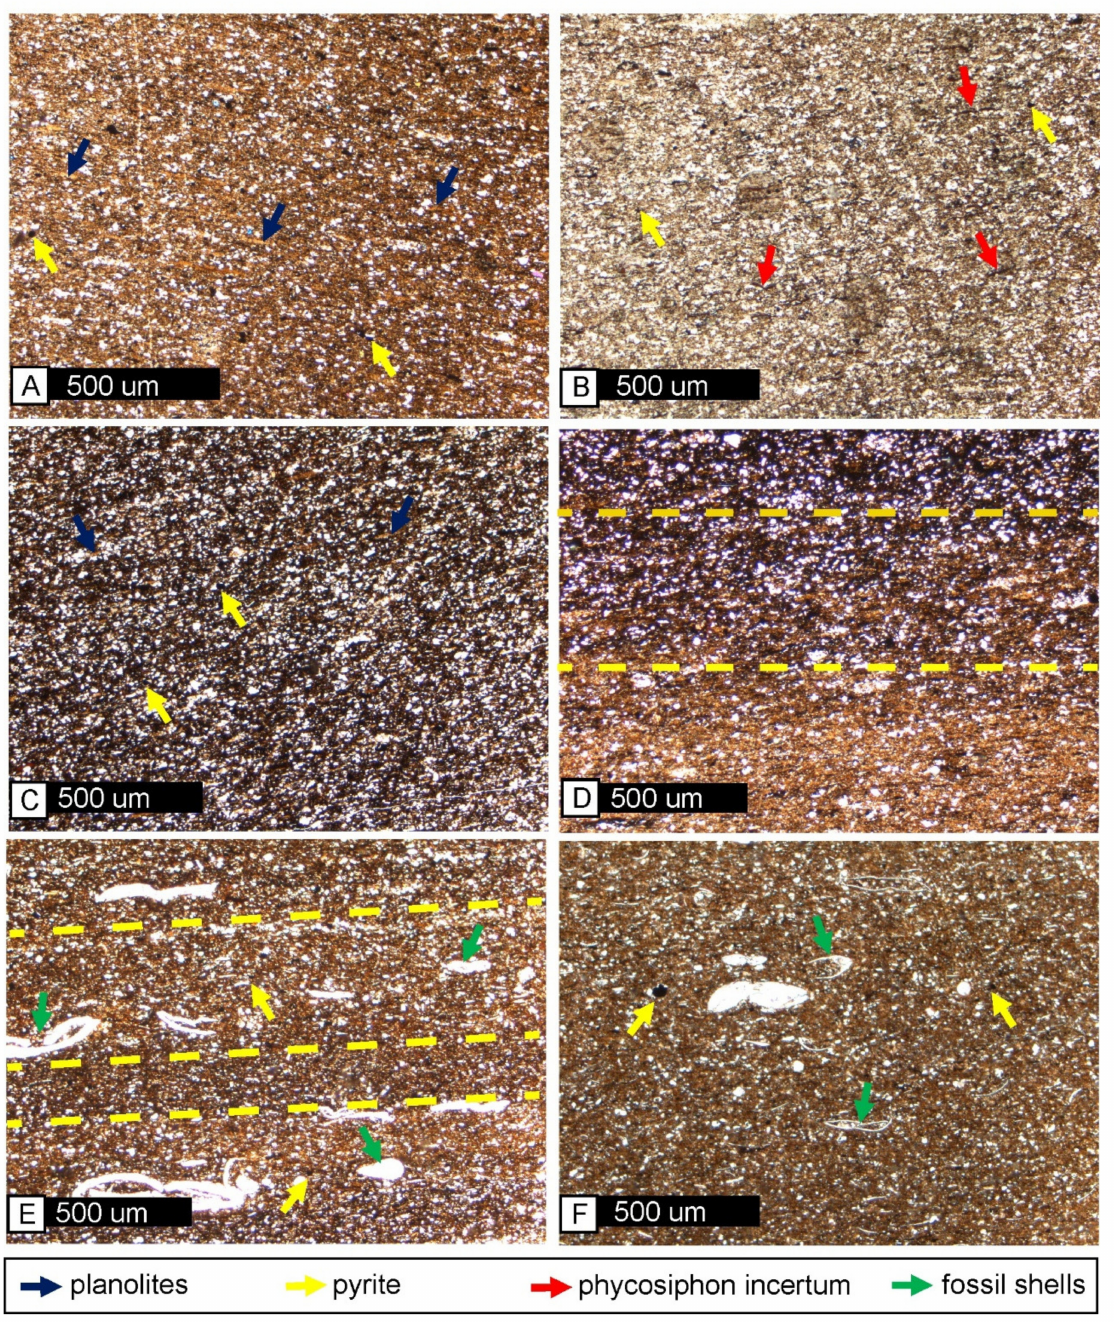
Figure 5. Plane light photomicrographs of mudstone lithofacies in the Oatka Creek Formation. ( A ) Bedded argillaceous mudstone (BAM). ( B ) Organic-poor bedded siliceous mudstone (Op-BSM). ( C ) Organic rich bedded siliceous mudstone (Or-BSM). ( D ) Gradational contact between argillaceous mudstone and organic-rich siliceous mudstone. ( E ) Laminated argillaceous mudstone (LAM). ( F ) Bedded argillaceous mudstone